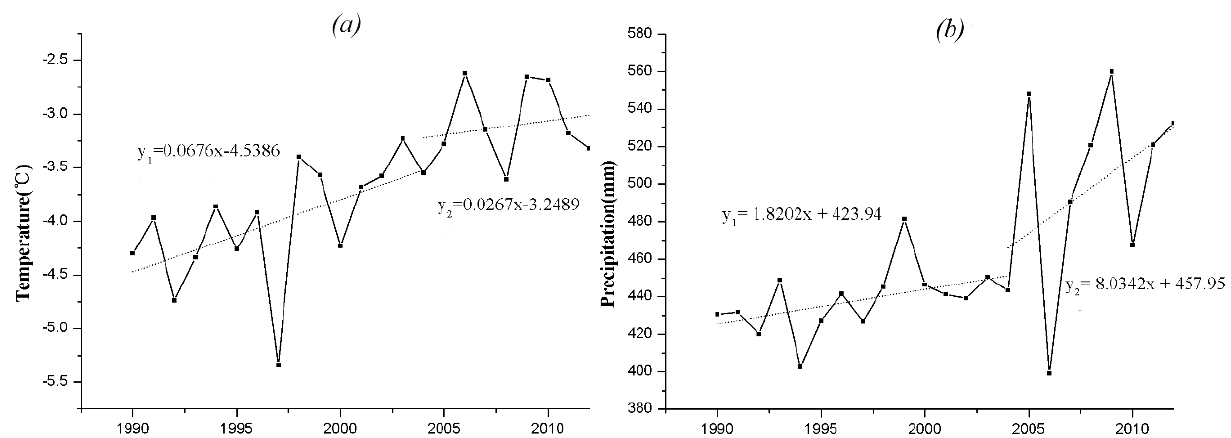
Figure 6. Change of average annual ( a ) temperature and ( b ) precipitation in the TRH